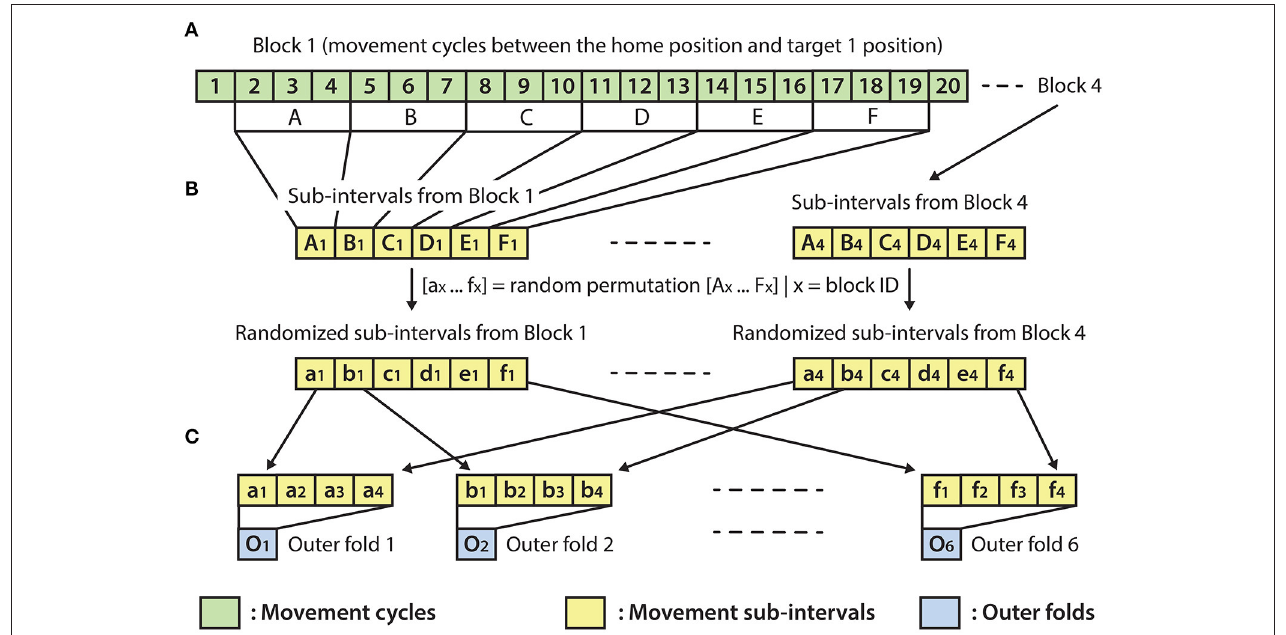
FIGURE 3 | Outer fold structure . (A) A block with 20 movement cycles from which movement cycles 2–19 were used for the present analysis. (B) Re-distribution of discrete movement sub-intervals (A x -F x ) in a randomized order (a x -f x ), done separately for each of the four blocks. (C) Preparation of the outer folds involving the homogeneous distribution of each of the four movement types, respectively, to the four targets (i.e., the data for each of the six outer folds were drawn from four randomly re-distributed discrete movement intervals, with a similar length, respectively, to the four targets).